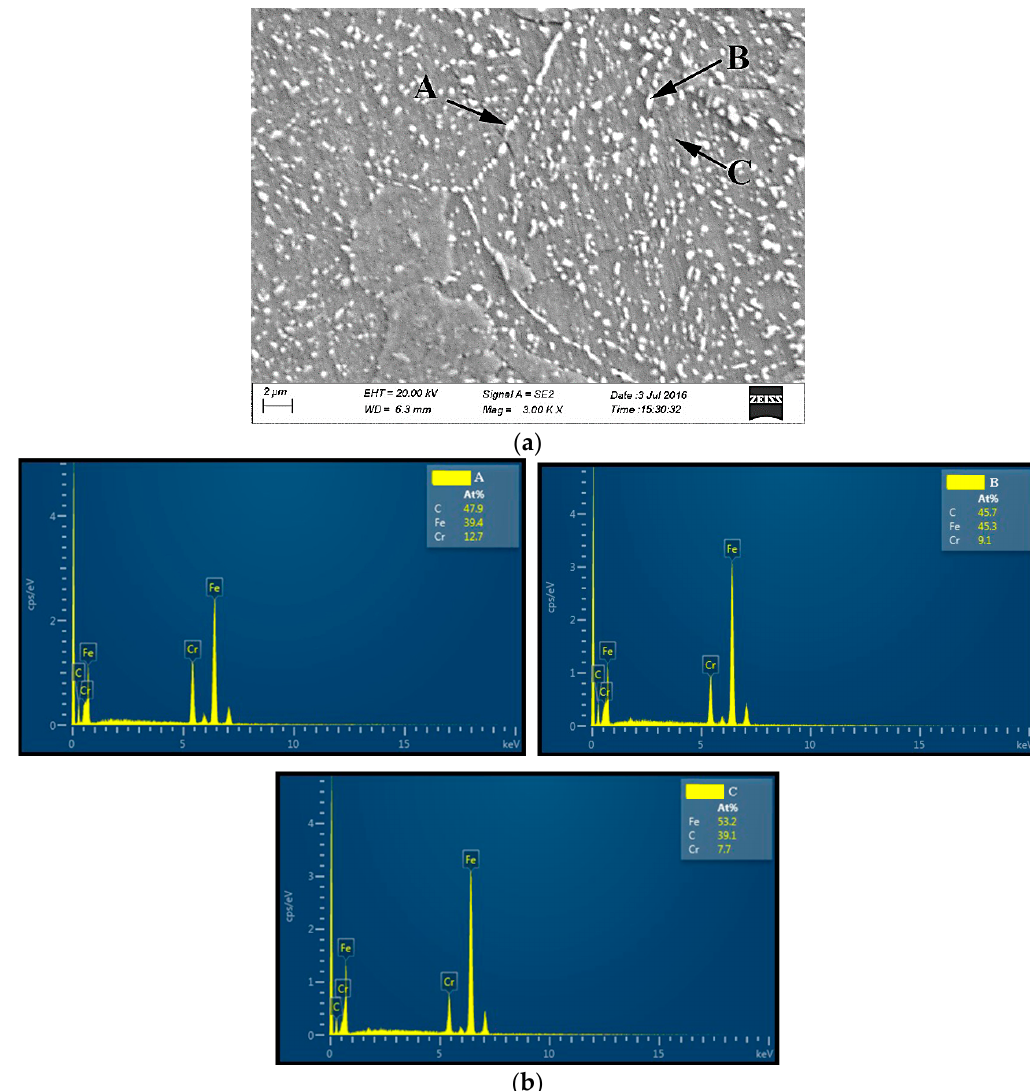
Figure 14. SEM and EDS analysis: X46Cr13 steel under uniaxial fatigue, 776 MPa/194 MPa, stress ratio R = 0.25, (average value of cycles to failure: 330,000). ( a ) Fractured surface of the specimen; ( b ) EDS analysis of Points A, B and C.